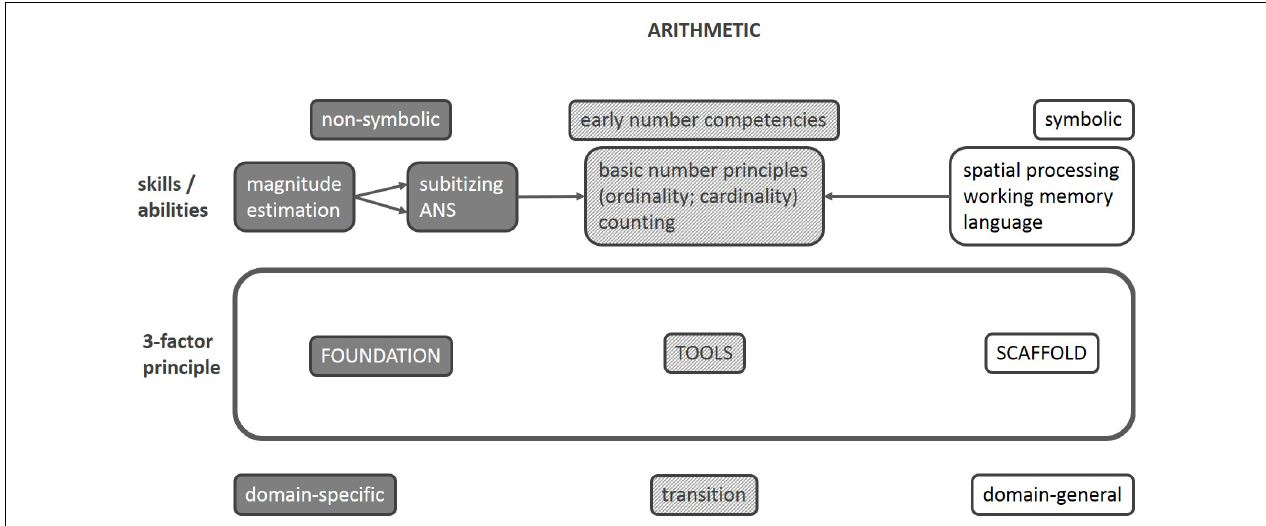
FIGURE 1 | Schematic illustration of the proposed three-factor model. Putative innate skills as well as supporting abilities both contribute to the acquisition of early number competencies required for successful